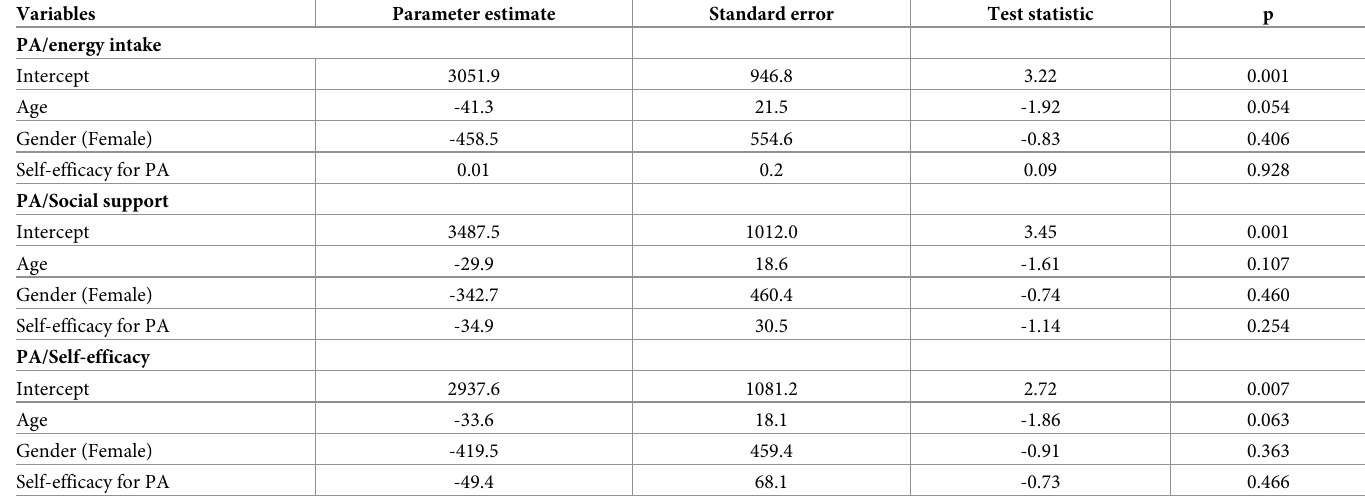
Table 4. Regression model results with Physical Activity (PA) as dependent variable and energy intake from diet, social support and self-efficacy for physical activ- ity, gender, and age as explanatory variables.